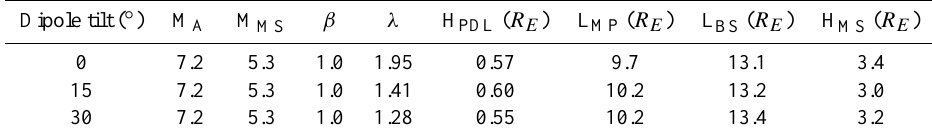
Fig. 13. The dependence of the PDL and the slow mode front on the Earth dipole tilt in the GSE y=0 plane: 0 ◦ , 15 ◦ , and 30 ◦ . The baseline solar wind parameters are used as model inputs: V =( − 450, 0, 0)km/s, B =(0, 0, 7)nT, N=6cm − 3 , and T p =T e =10eV. The other formats of this figure are the same as those in Fig. 3. Table 6. The dependence of some important parameters along the Sun-Earth line on the Earth dipole tilt. Dipole tilt ( ◦